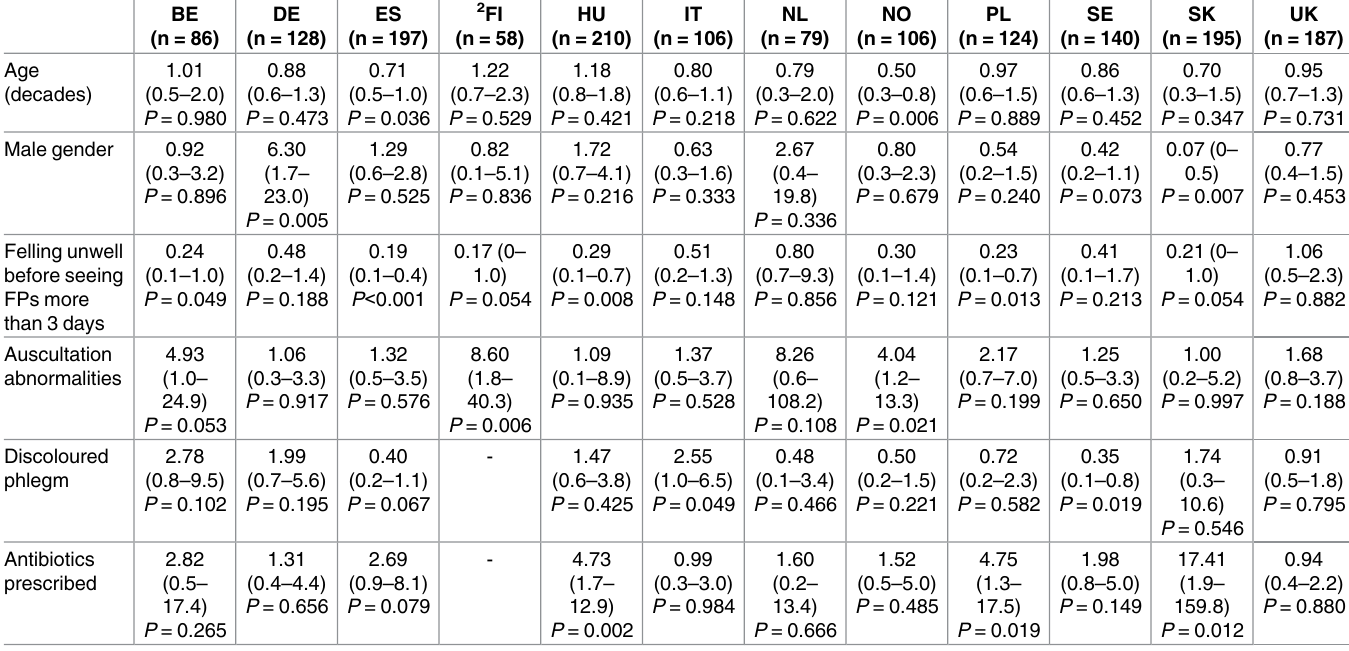
Table 5. Predictors of advising off work among working patients with LRTI by country of residence (network). BE—Belgium, DE—Germany, ES— Spain, FI—Finland, HU—Hungary, IT—Italy, NL—Netherlands, NO—Norway, PL—Poland,SE—Sweden, SK—Slovakia, UK—UnitedKingdom. Table presents the odds ratios with 95% CI based on results of multilevel mixed-effects binomial logistic regressionwith family practitioners fitted as random